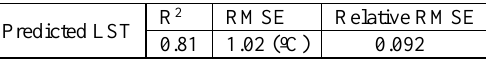
Table 4. The accuracy of the predicted LST using PLSR